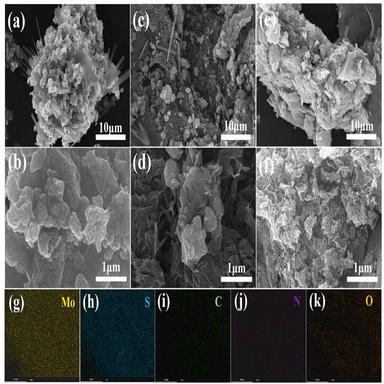
SEM images of (a-b) MoS2, (c-d) MoS2/G and (e-f) MoS2/C@G; (g-l) elemental (C, N, O, Mo, S) mapping of MoS2/C@G.